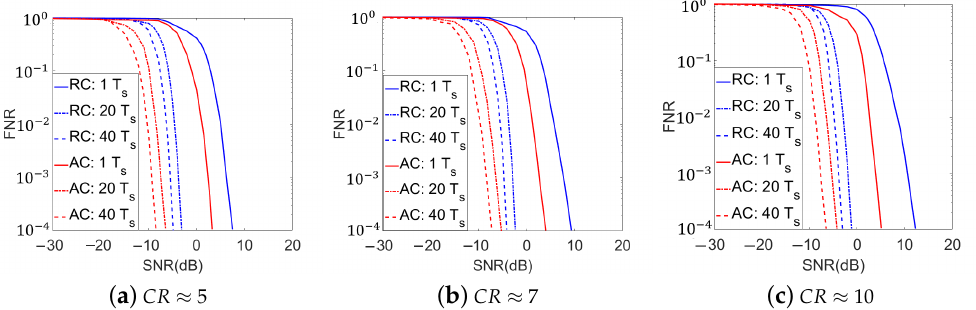
Figure 8. Simulated Detection Accuracies over Multiple Symbol Periods with the Multiple Neural Network Strategy for the Proposed Adaptive Method (RC: Conventional compressive detection with random measurement kernels; AC: Adaptive compressive detection with the multiple neural network strategy. T s represents the time of one symbol